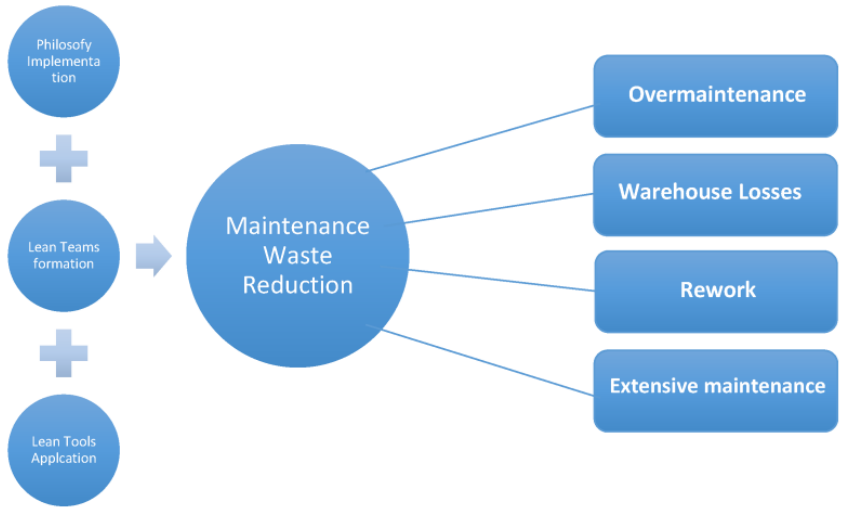
Figure 2. Effects of lean principles in maintenance functions.